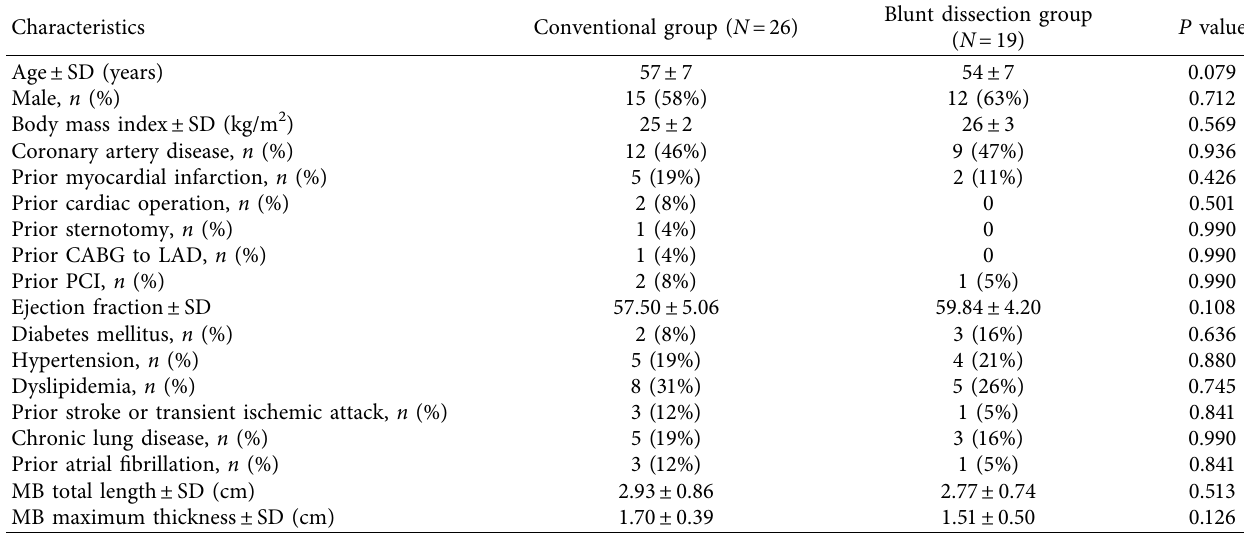
Table 1: Demographic and baseline characteristics in the study population including risk factors of the traditional coronary heart disease.